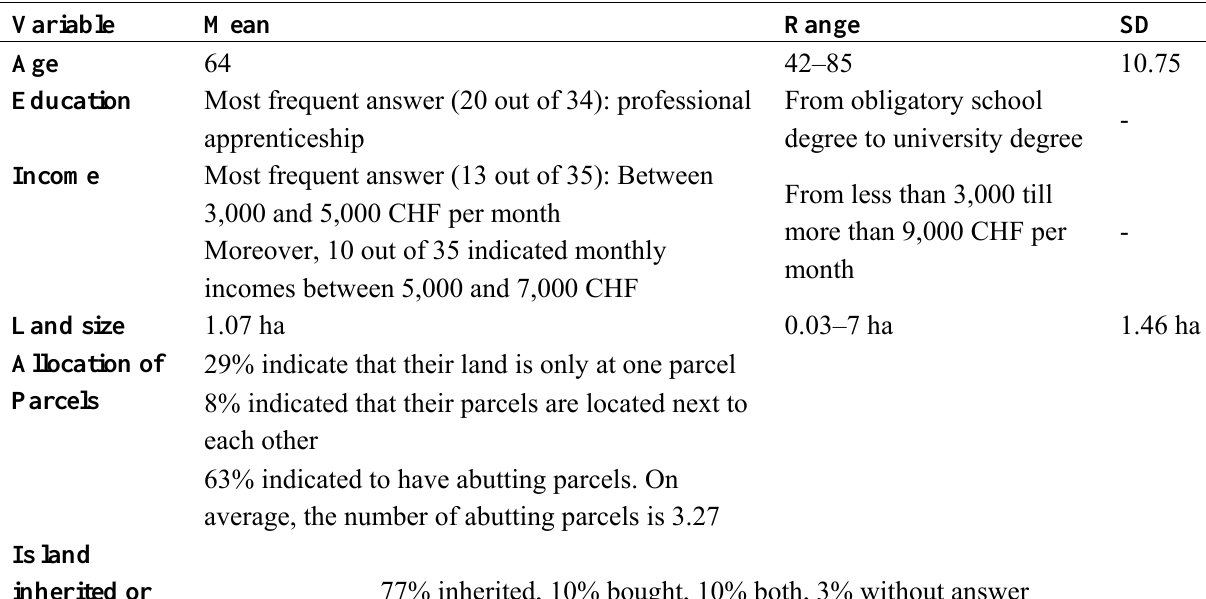
Table 2. Characteristics of community members and irrigation